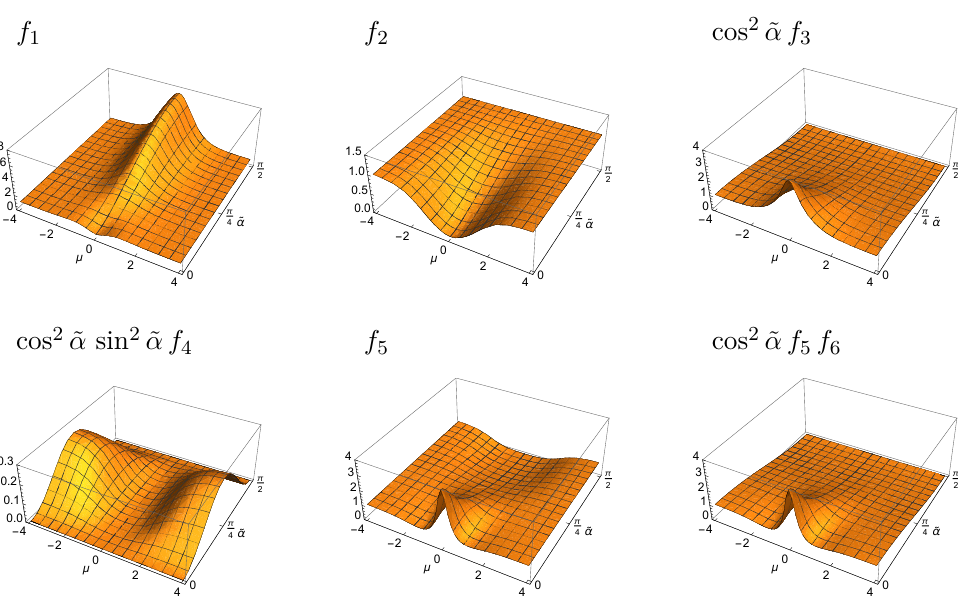
Figure 4 . Regular metric functions in (3.8) for the Janus solution with α = 1 and β = 0